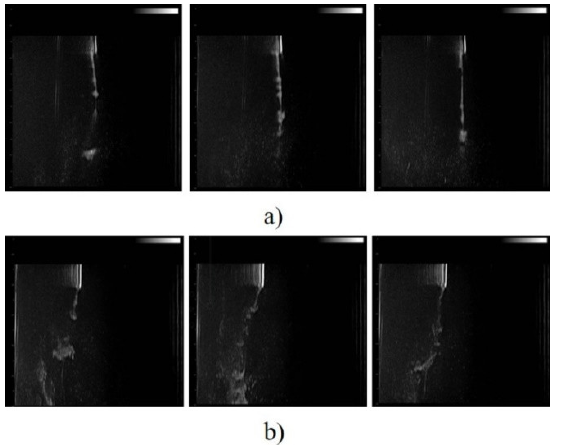
Figure 12. US imaging snapshot of MOLNBs in the absence ( a ) and the presence ( b ) of the magnetic field generated by two magnets (distance 4 cm from each other). Images were recorded at different time frames (5, 15, 30 s) from the injection.